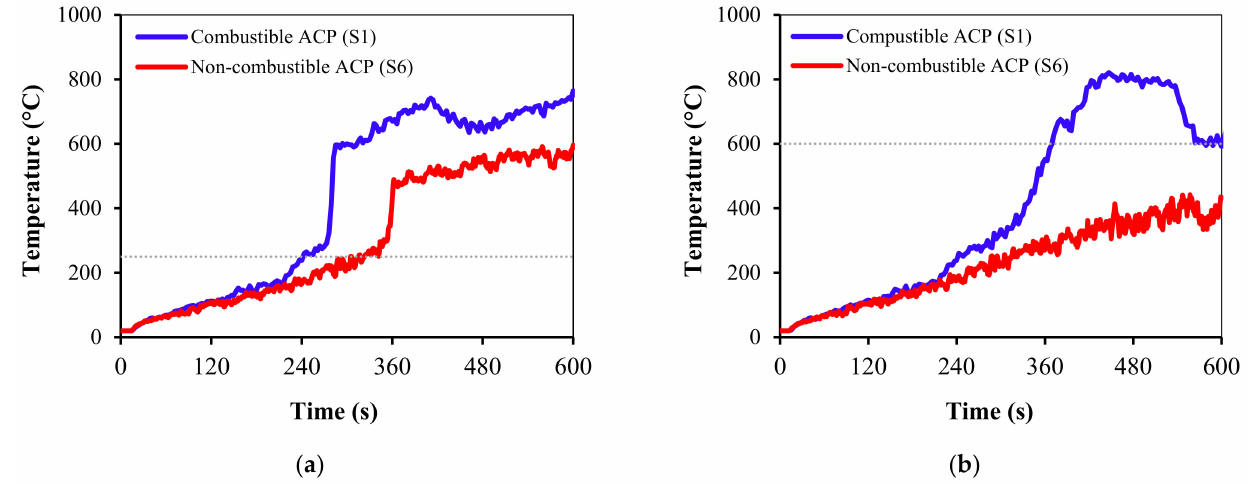
Figure 16. Effect of combustibility on ( a ) Internal temperature ( b ) External temperature.